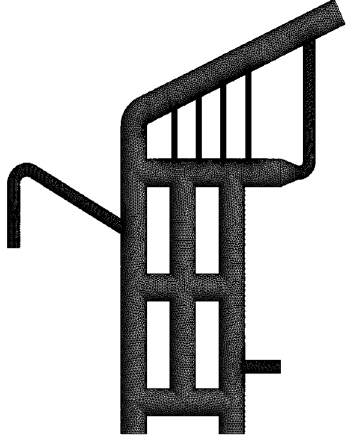
Figure 2. Mesh generation of the physical model.